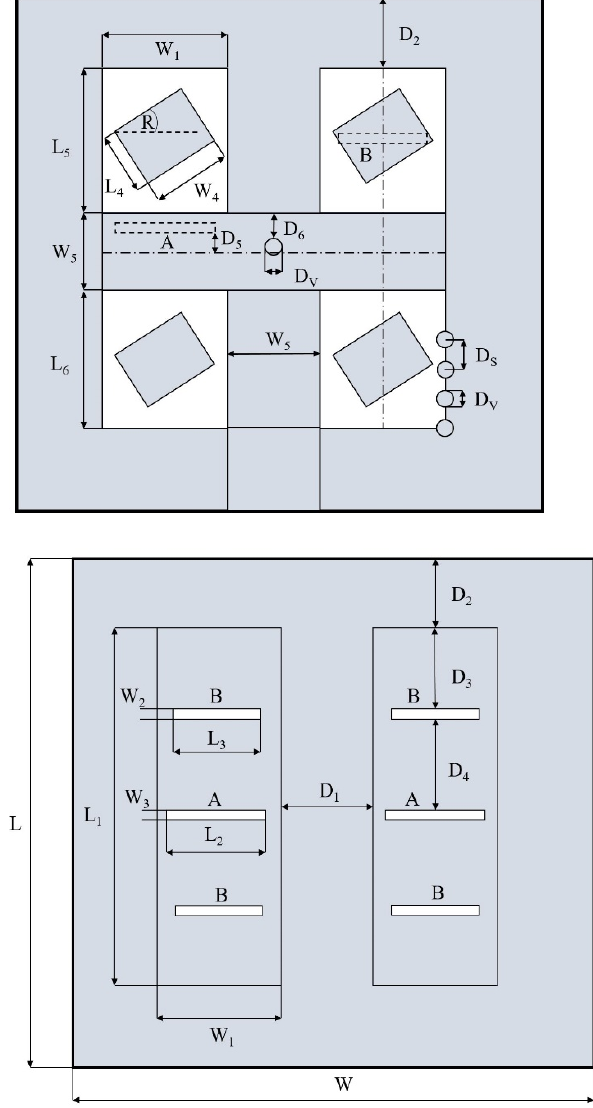
Figure 14. Dimensions of the array for the center frequency of 60 GHz for the top layer ( top ) and the bottom layer ( bottom ).